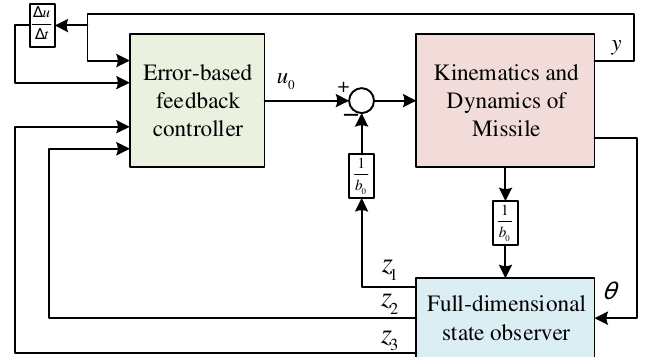
Figure 3. Block Diagram of Active Disturbance Rejection Tracking Controller.